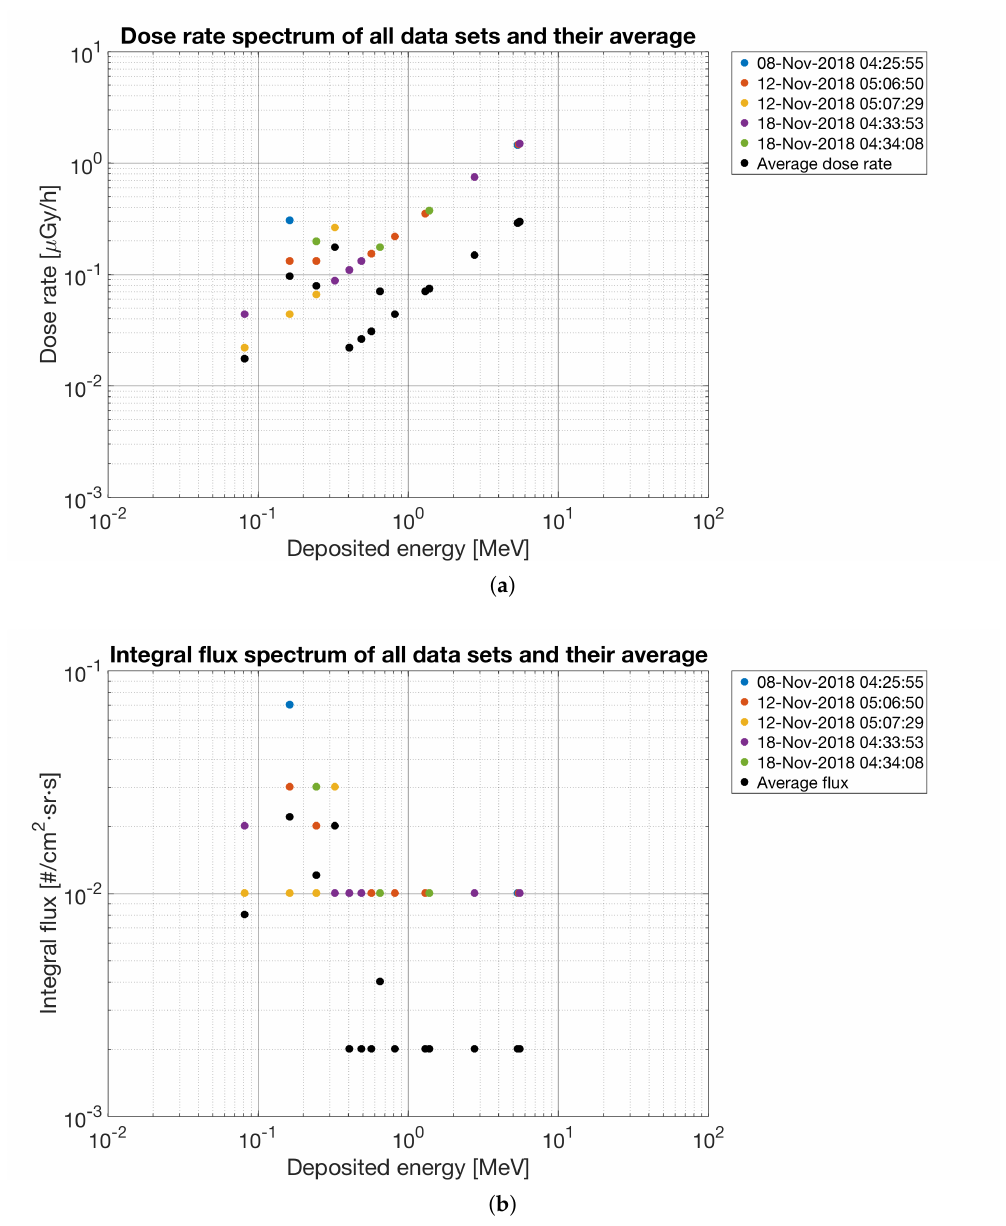
Figure 11. Dose rate and flux spectra obtained from the real time operation mode for the first CPD-Liulin data measurements on November 2018 during the early operation phase of Ten-Koh satellite: ( a ) dose rate spectrum for each dataset and the average spectrum measured inside Ten-Koh spacecraft; and ( b ) integral flux spectrum for the 5 real time datasets and the average flux spectrum measured inside the